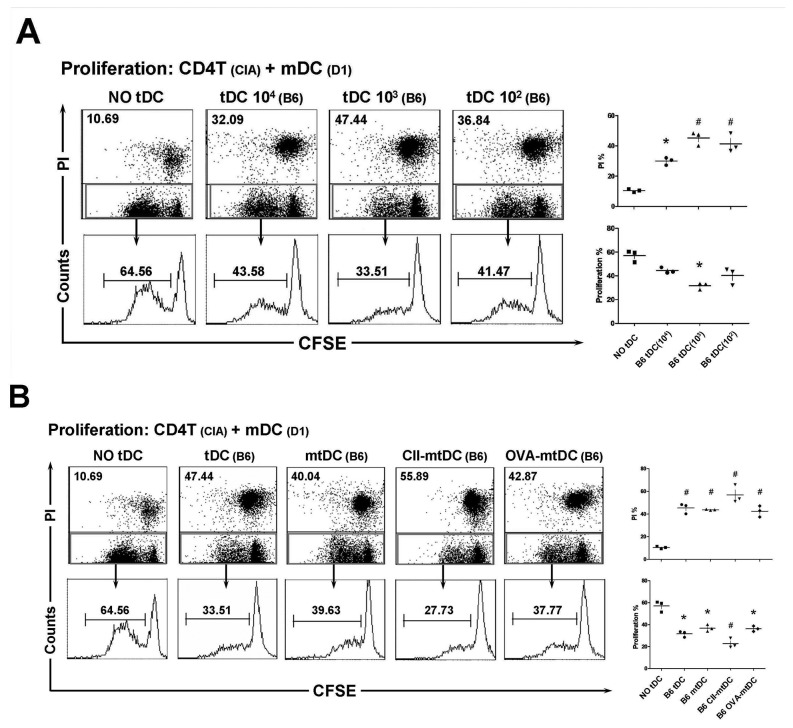
Allo-tDCs exhibited potent immunosuppressive activity in antigen-specific CD4+T cell proliferation when at a suitable S: R ratio in vitro.In the proliferation assays, CD4+T cell (responders) were isolated from CIA mice (H-2Kq) SC, which were then stained with CFSE, and stimulated with CII-loaded mDCs (stimulators) derived from bone marrow precursors of normal D1 mice. (A) Different doses of allo-tDCs (suppressors) from B6 mice were added to the proliferation assay, at a suppressor: responder (S:R) ration of 1:10, 1:100 and 1:1000. (B) Different sub-types of modified allo-tDCs were added to the proliferation assay, at an S:R ratio of 1:100. After co-culture for 4 d, cells were harvested and analyzed by FACS. Progressive dilution of CFSE and the rate of PI positive cells were used as measures of proliferation and apoptotic death of responder cells respectively. The results are representative of three independent experiments. *P <0.05 and # P <0.01, as compared with No-tDCs group by unpaired t-tests.